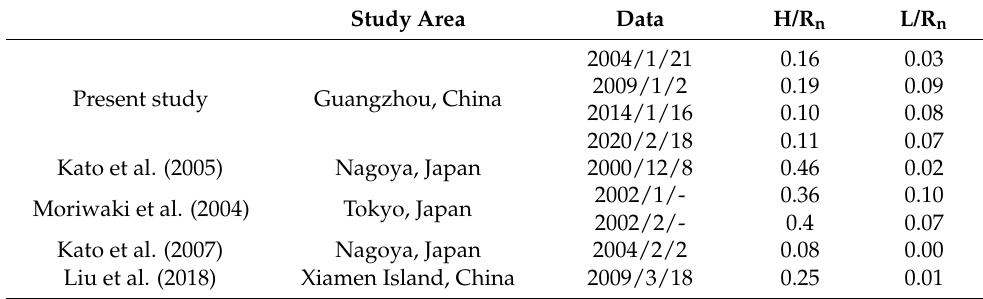
Table 9. Heat fluxes ratios to net radiation between the present study and previous studies